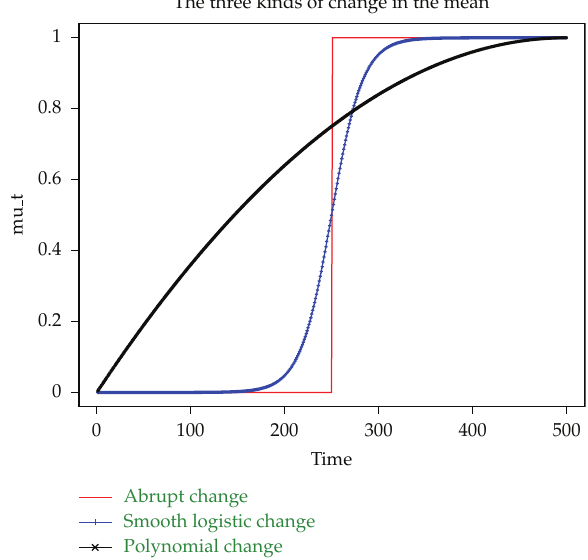
Figure 1: The three kinds of change in the